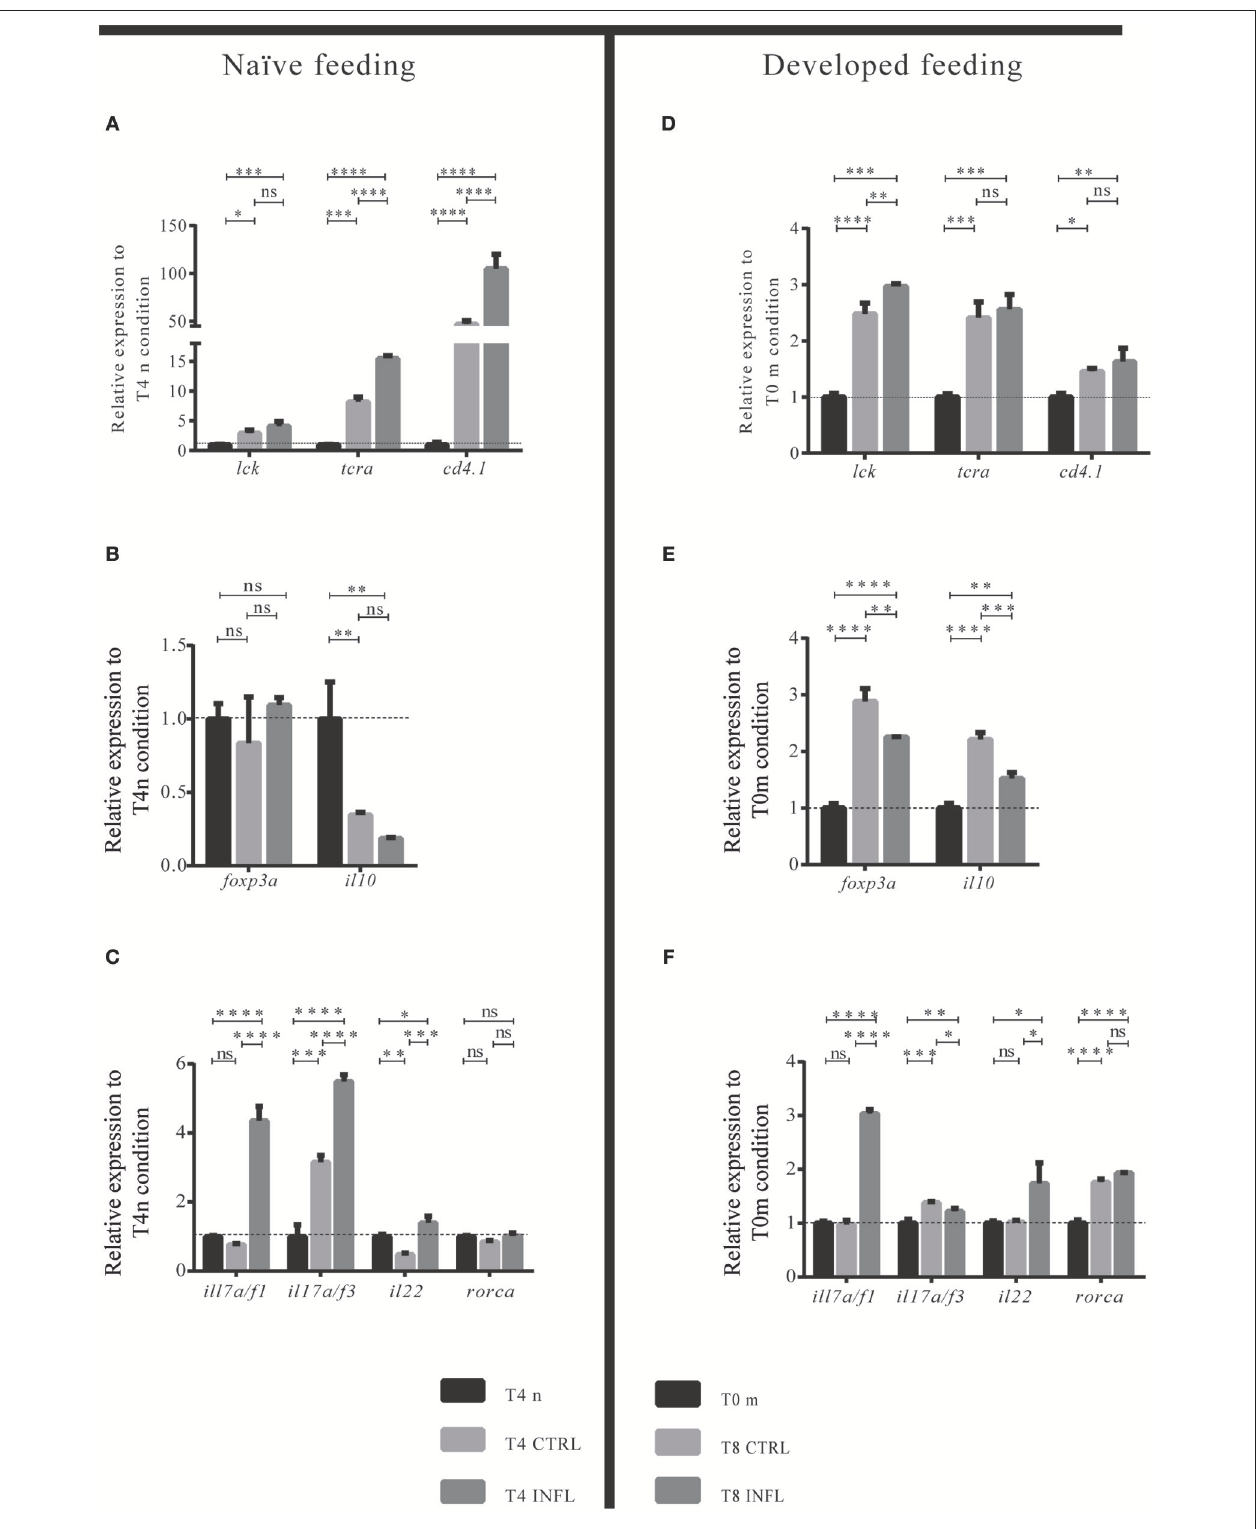
FIGURE 4 | Intestinal lymphoid cells are CD4 + T cells with a Th17-like transcriptional profile. (A–F) Relative transcriptional level of lymphoid-associated genes was analyzed. Data was normalized against rpl13a and compared to the naïve condition (T0n; dotted line) or to the maintenance condition, T0m. For each condition, 100 guts were analyzed, and three biological replicates were made. * p < 0.05; ** p < 0.01; *** p < 0.001; **** p > 0.0001.